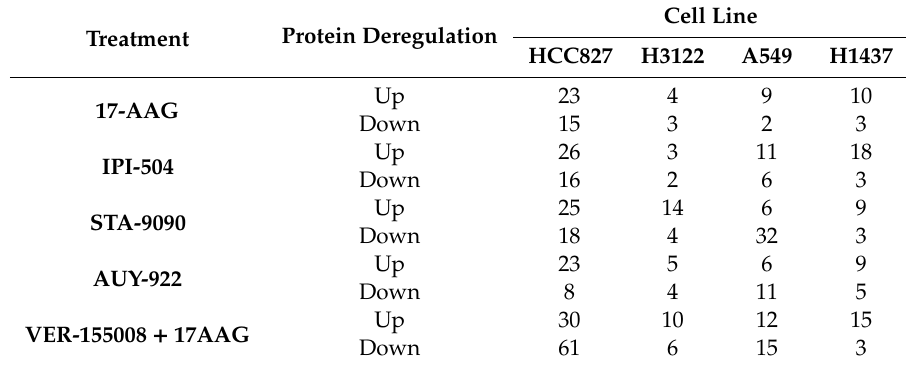
Table 3. Number of di ff erentially expressed proteins identified in the studied cell lines for the di ff erent